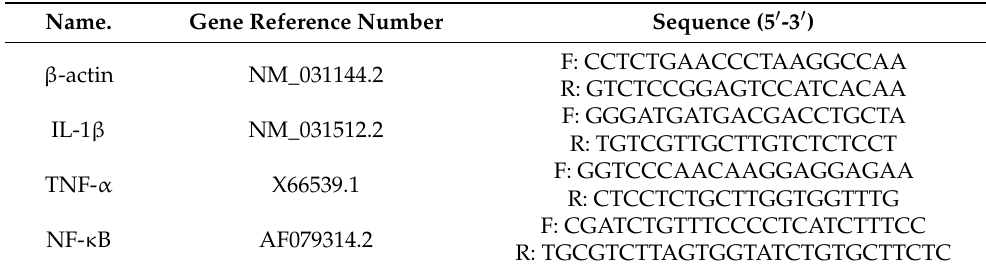
Table 2. qPCR primers used in the present